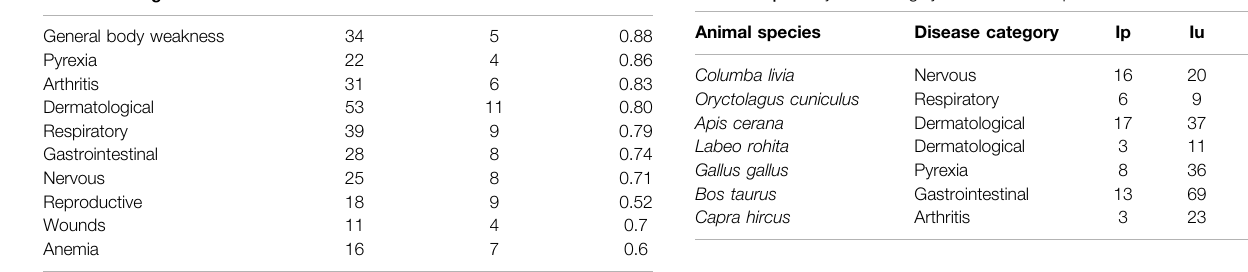
FIGURE 6 | Modes of administration of ethnomedicine. TABLE 5 | Fidelity level of highly utilized animal species in traditional therapies.